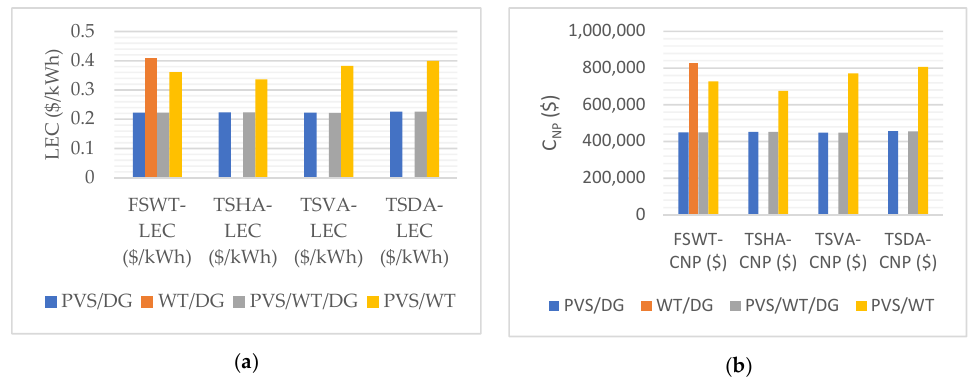
Figure 5. Cost for different tracking systems in various configurations ( a ) LEC ($/kWh); ( b ) net present cost ‘C NP ’ ($). more in the system with WT/DG using FSWT at 119,538.9 kg/yr. In FSWT, the system consisting of PVS/DG has less emission of 12,228.4 kg/yr, which is 89.68% lower than WT/DG. However, for PVS/WT configuration, the emission is nil for the system with var- ious tracking techniques. The system consisting of PVS/DG and PVS/WT/DG with TSHA produces the same emission of 12,449 kg/yr. The system consisting of PVS/DG and PVS/WT/DG with TSVA produces emission of 13,755 kg/yr and 14,043 kg/yr, respectively. The system consists of PVS/DG and PVS/WT/DG with TSDA produces emission of 14,265.6 kg/yr and 15,823.6 kg/yr, respectively.